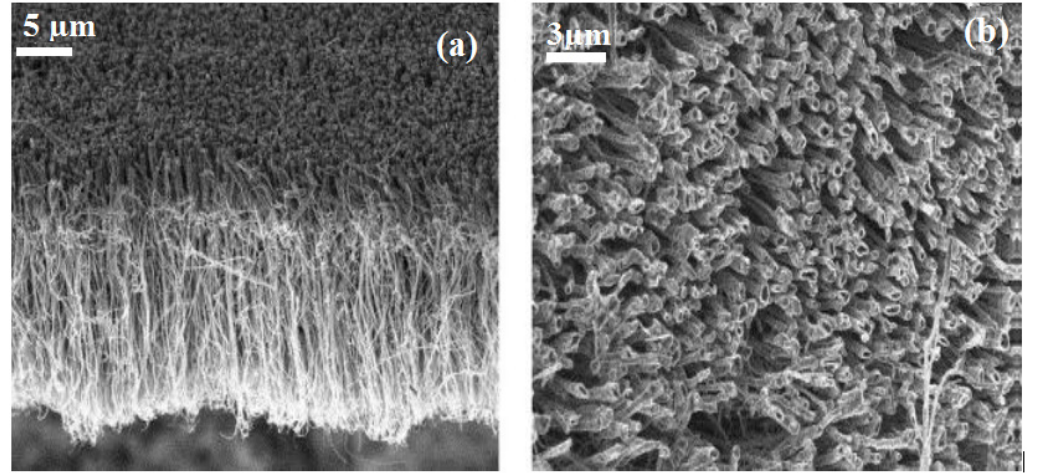
Figure 2. TEM pictures illustrating CNT orientation observed in ( a ) the lateral direction and ( b ) the longitudinal direction [69].